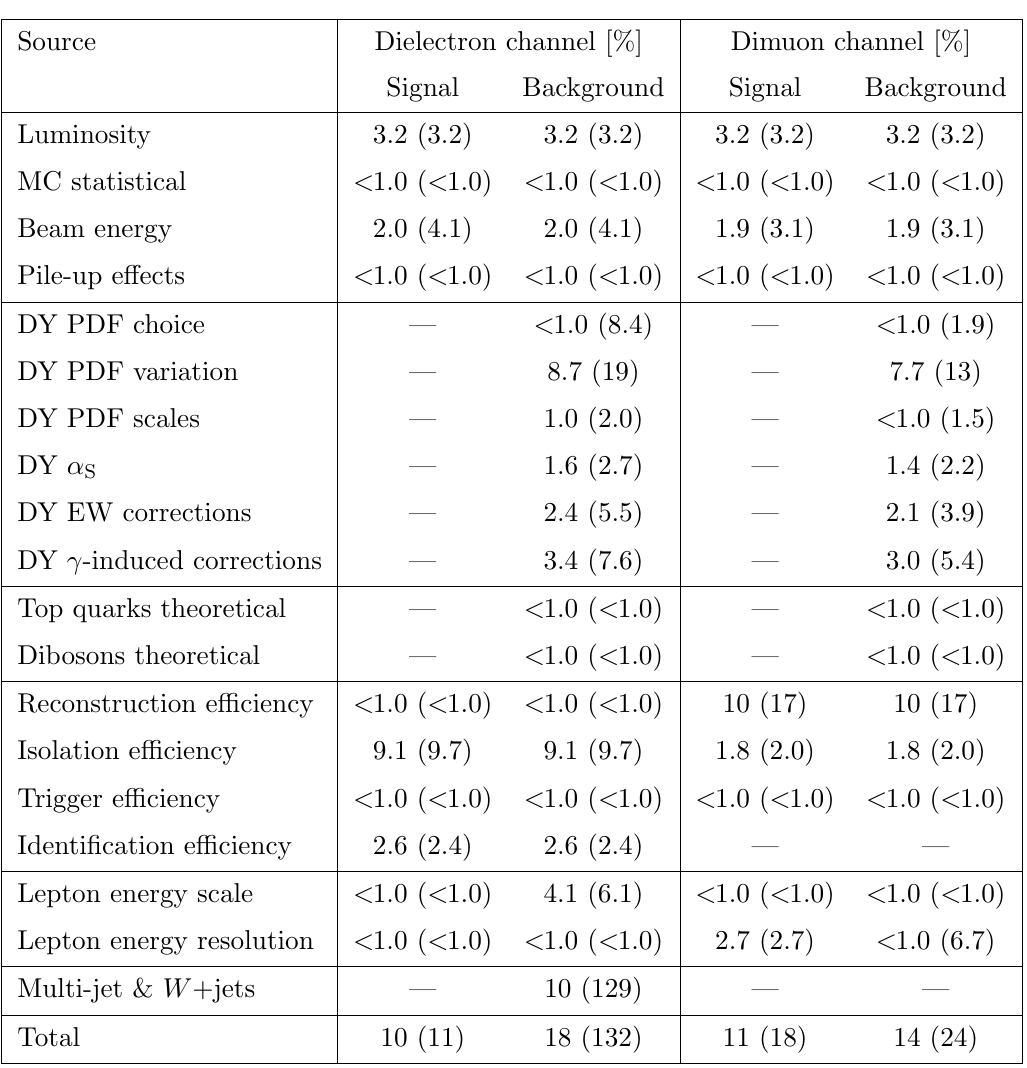
Table 2 . Summary of the pre-marginalised relative systematic uncertainties in the expected number of events at dilepton masses of 2 TeV and 4 TeV. The values reported in parenthesis correspond to the 4 TeV mass. The values quoted for the background represent the relative change in the total expected number of events in the corresponding m ‘‘ histogram bin containing the reconstructed m ‘‘ mass of 2 TeV (4 TeV). For the signal uncertainties the values were computed using a Z 0 model with a pole mass of 2 TeV (4 TeV) by comparing yields in the core of the mass peak (within the full width at half maximum) between the distribution varied due to a given uncertainty and the nominal distribution. \|" represents cases where the uncertainty is not